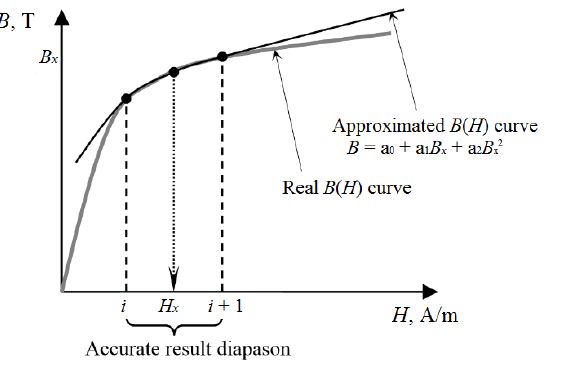
Fig. 8. Polynomial approximation of Excel.